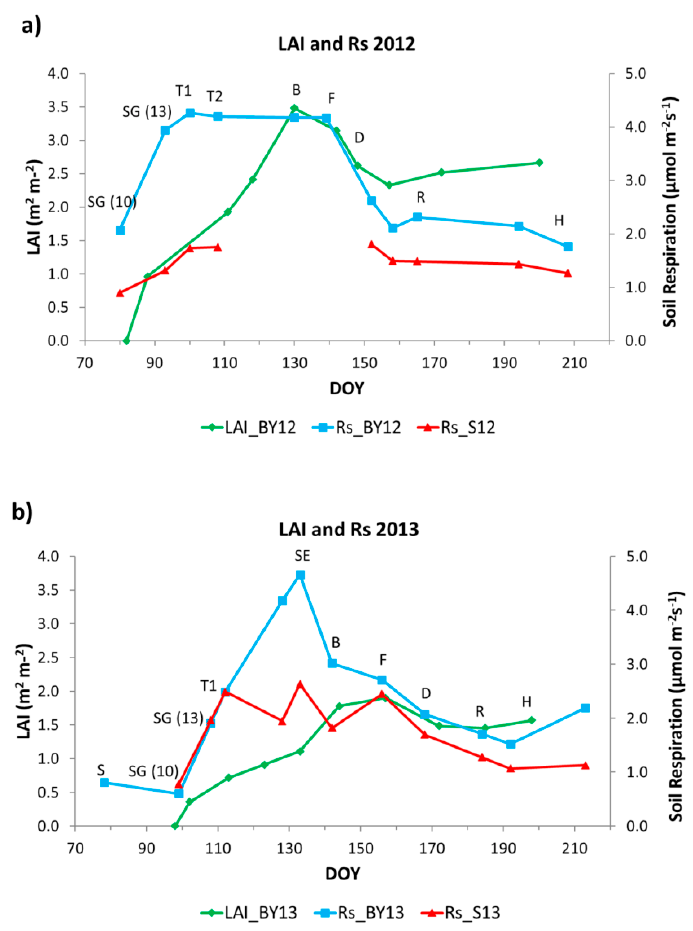
Figure 3. Leaf area index (LAI) and soil respiration (Rs) average values measuredin the BY1 and BY2 barley plotsand in the bare soil plot (S) in 2012 ( a ) and in 2013 ( b ) in Madrid, Spain.